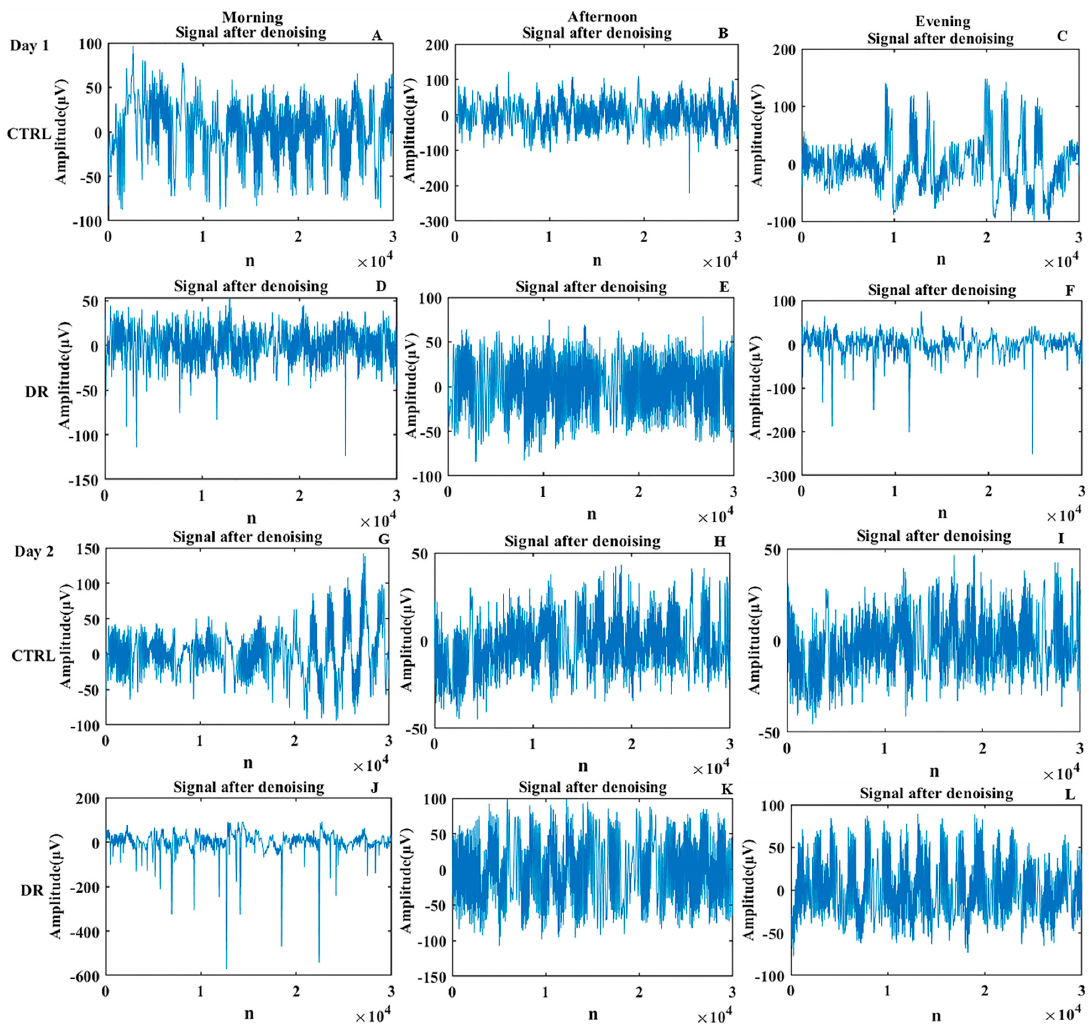
Figure 3. The denoising results on Day 1 and Day 2. Graphs ( A – C ) correspond to the results of the